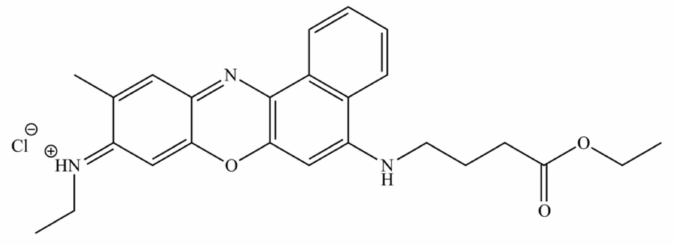
Figure 1. Chemical structure of N -(5-((4-ethoxy-4-oxobutyl)amino)-10-methyl-9 H - benzo[ a ]phenoxazin-9-ylidene)ethanaminium chloride